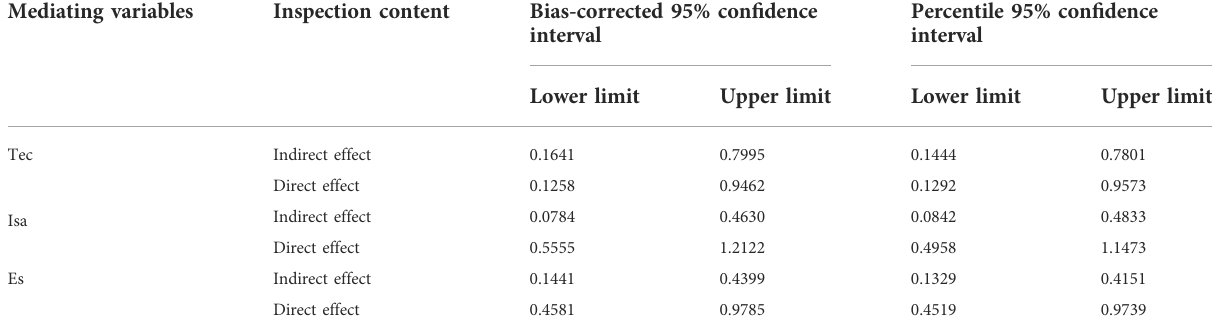
TABLE 7 The results of bootstrap